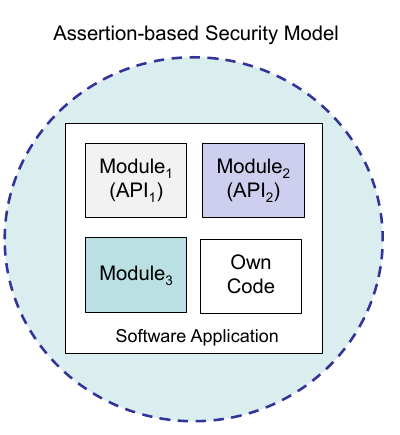
Figure 4. Deploying Assertion-based Security Models over a Multi-moduleApplication.